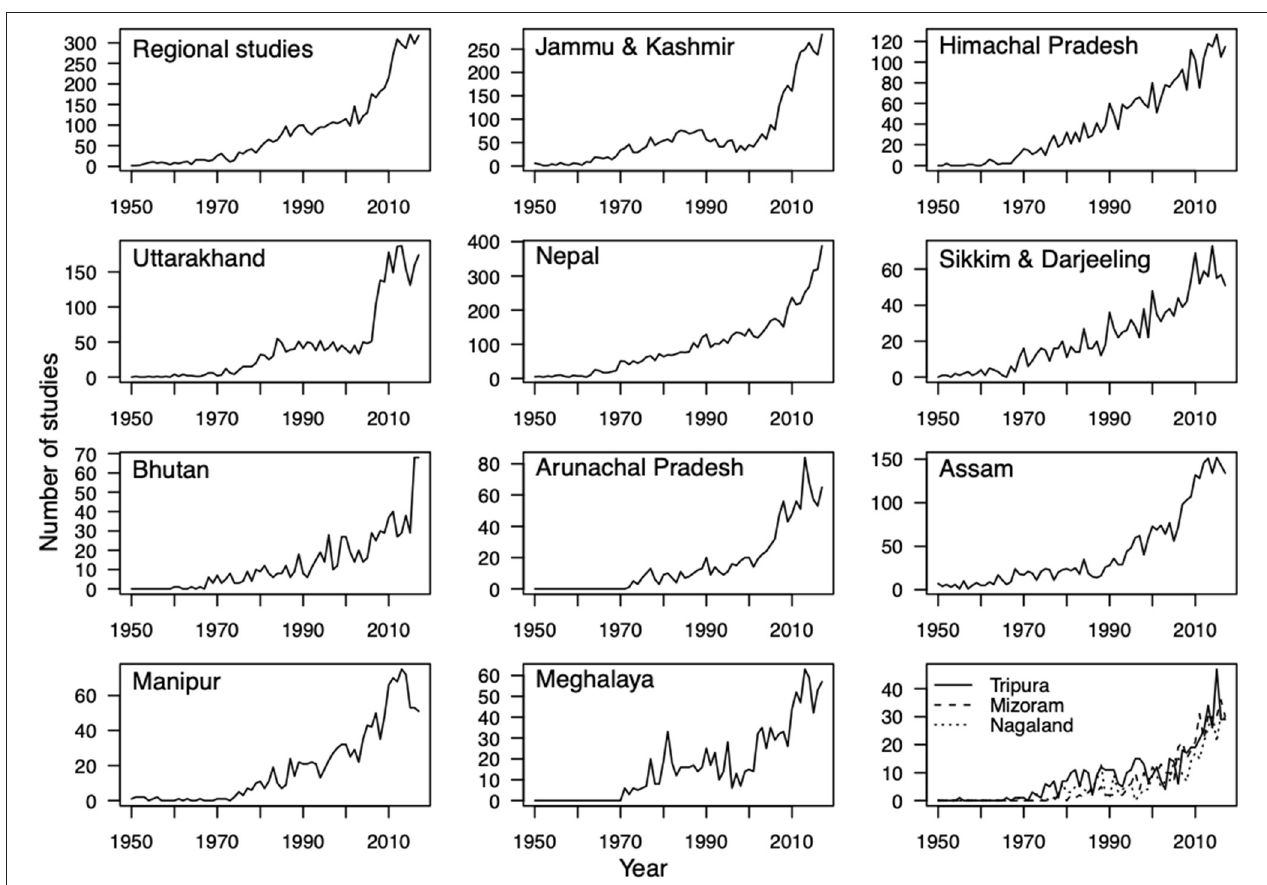
FIGURE 5 | Temporal tends (1950–2018) of publications within the 11 Indian Himalayan and northeastern states, Nepal, and Bhutan.